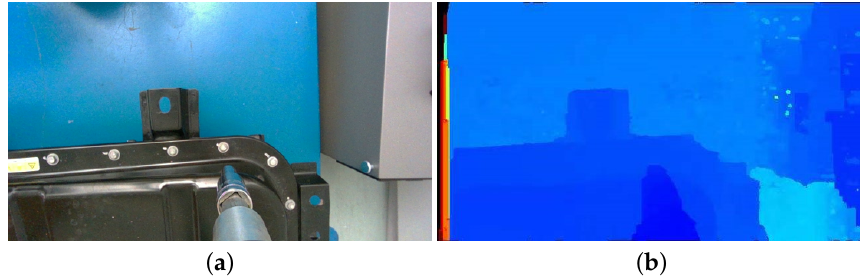
Figure 17. RGB image ( a ) and depth image ( b ) captured by the vision sensor after adaptive pose and position adjustment.